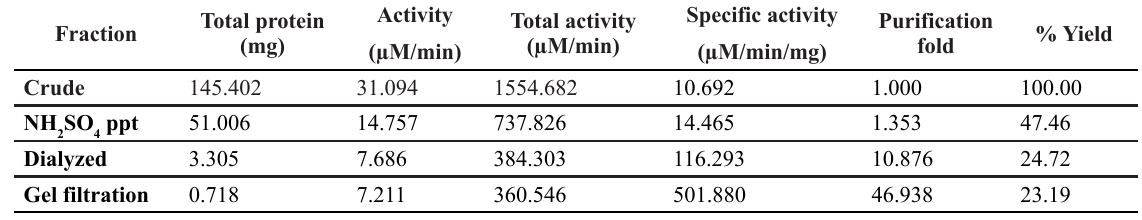
Table 2: Summary of purification process of C. lanatus rind invertase from crude extract to gel filtration step. Activity Total protein Fraction (mg) (µM/min)